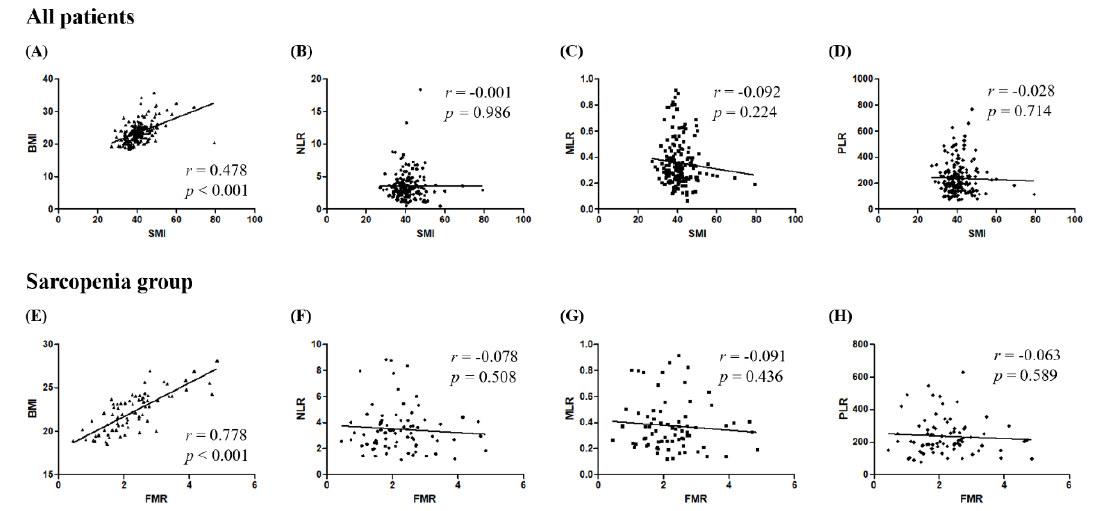
Figure 3. Correlations between body composition and systemic inflammatory indices. (Upper) Analyses according to skeletal muscle index in all patients; (Lower) analyses according to fat to muscle ratio in sarcopenia patients. ( A , E ) Body mass index; ( B , F ) neutrophil-to-lymphocyte ratio; ( C , G ) monocyte-to-lymphocyte ratio; ( D , H ) platelet-to-lymphocyte ratio.